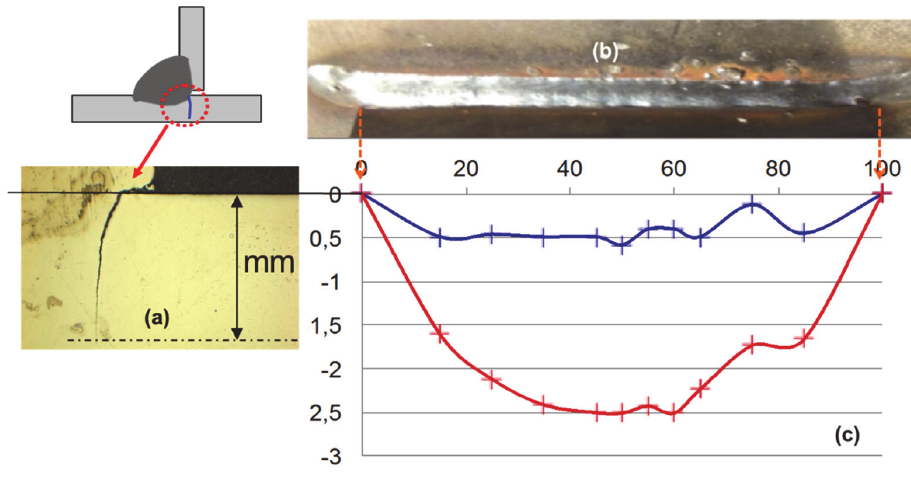
Figure 2: (a) Fatigue crack depth from the surface; (b) general view of the welded junction; (c) crack depth profile in